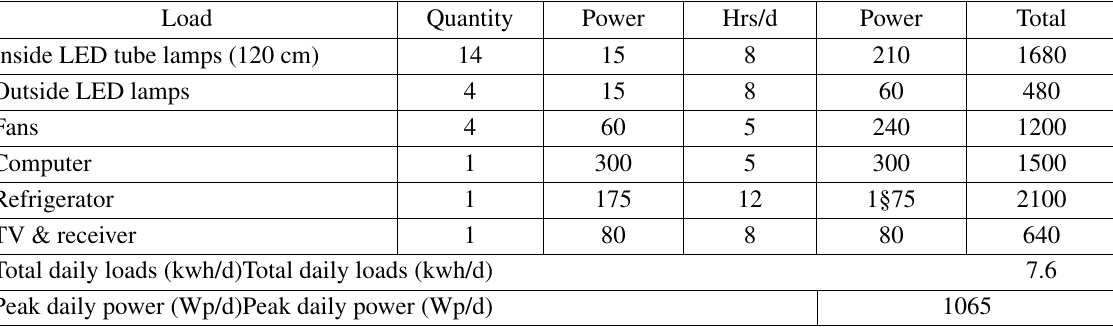
Table 1. Daily load profile of the prototype residential